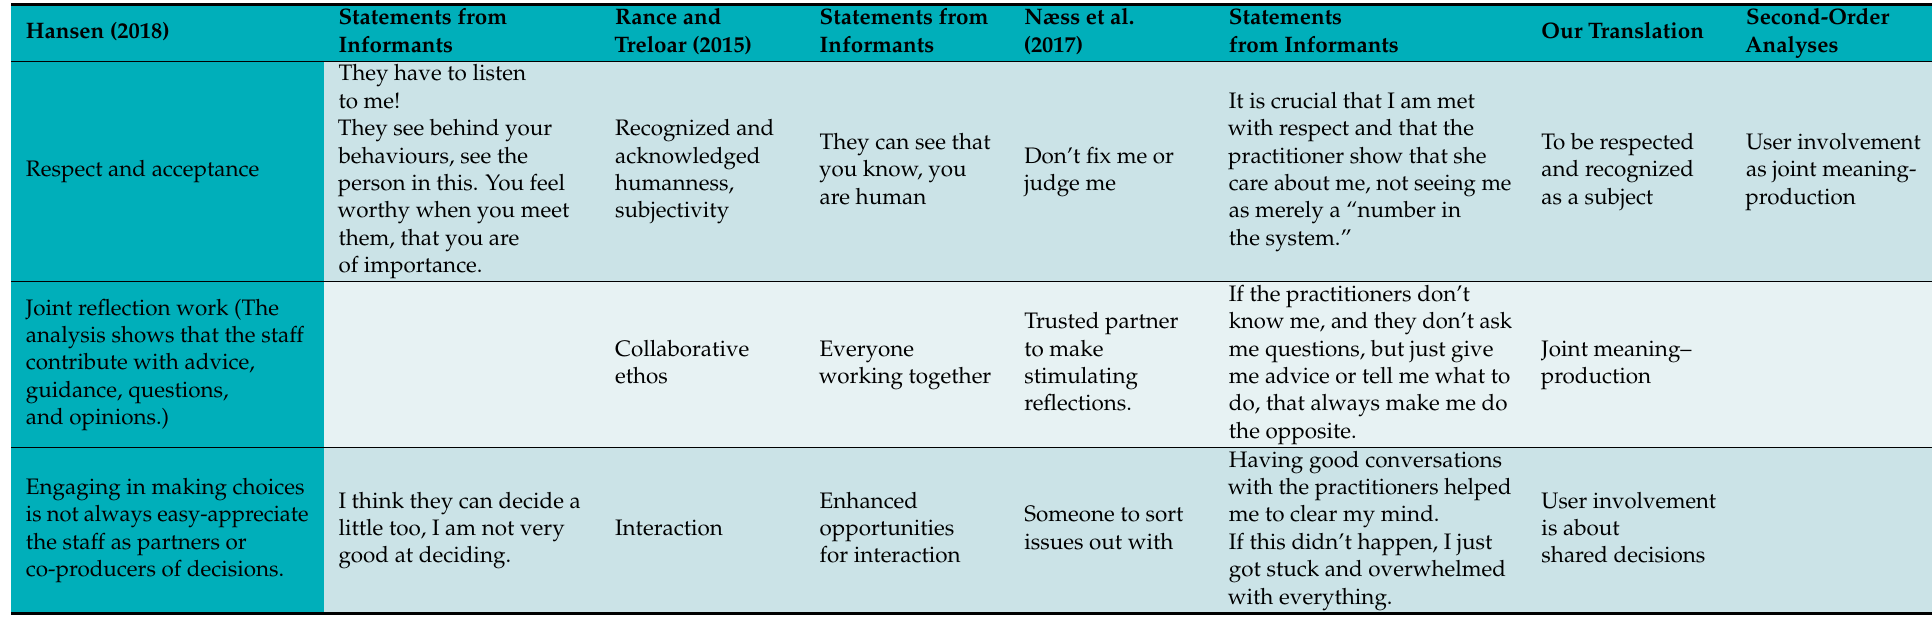
Table 3. Example of grid for reciprocal translation; content issues from the primary articles about understandings and experiences of user